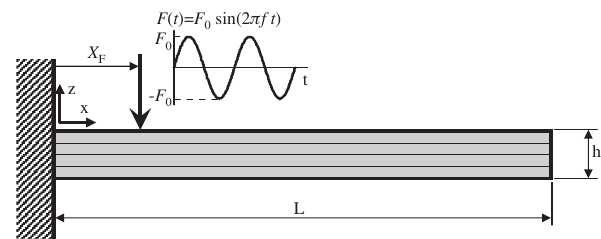
Figure 1 Clamped-free composite beam subjected to harmonic